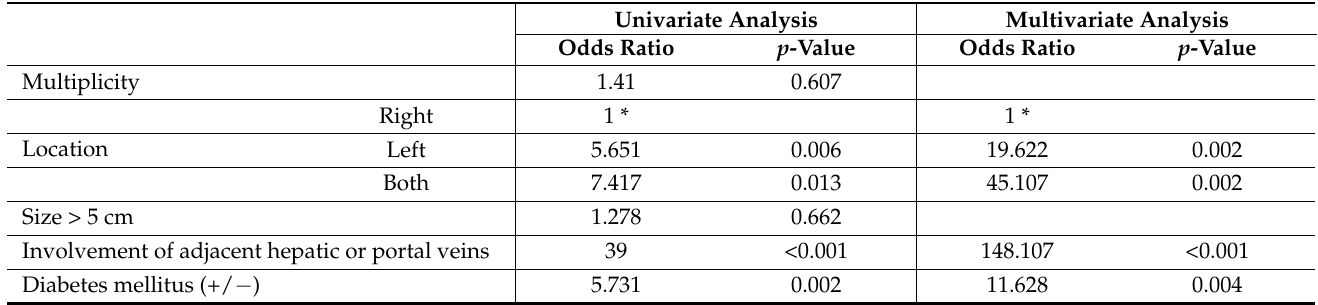
Figure 3. Representative images of an 87-year-old man with diabetes mellitus who presented endogenous endophthalmitis due to Klebsiella pneumoniae -related pyogenic liver abscess. ( A ) This patient had biliary cirrhosis due to recurrent pyogenic cholangitis and underwent contrast computed tomography (CT) examination. The CT image showed a 6.8 cm septated cystic lesion, representing a Klebsiella hepatic abscess, at liver segments II and IV. The CT image also showed the hepatic abscess with invasion from the adjacent hepatic vein (arrow). ( B ) Severe corneal edema and anterior chamber haziness were noted during an initial slit-lamp examination without history of previous ocular surgery. ( C ) Despite aggressive treatment, his eye developed phthisis. Table 3. Logistic regression analysis of the risk factors for endogenous endophthalmitis.